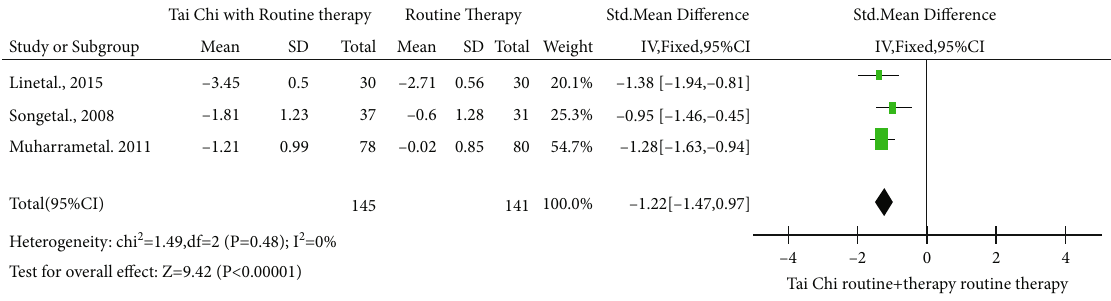
Figure 4: Forest plot of Tai Chi with routine therapy vs. routine therapy. Table 4: Subgroup analysis of Tai Chi vs. control group (unaltered lifestyle).